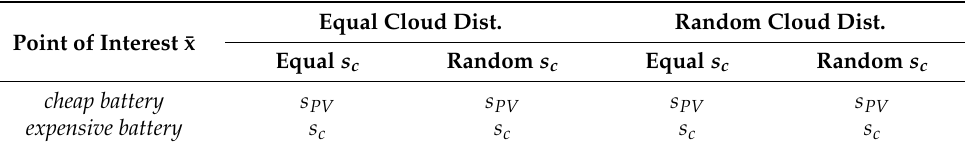
Table 2. Output of the proposed methodology for the electricity-only ESD model. The most relevant interpretable features for the cost-optimal battery capacity using different cloud mappings h ¯x are shown. Interpretable features are the cloud size s c , the number of clouds n c , the storable PV surplus s PV , specific battery investment costs p b , and morning mist m m . Equal Cloud Dist. Random Cloud Dist. Point of Interest ¯x Equal s c Random s c Equal s c Random s c cheap battery s PV s PV s PV s PV expensive battery s c s c s c s